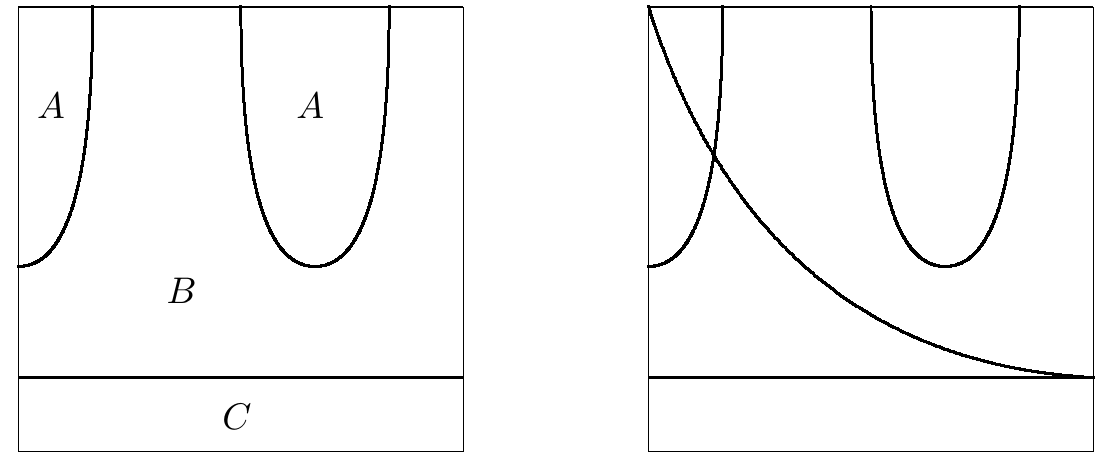
π ( φ , s ) ( ] , 0.4 < s < 1 φ , π 6 3 { | ∈ −